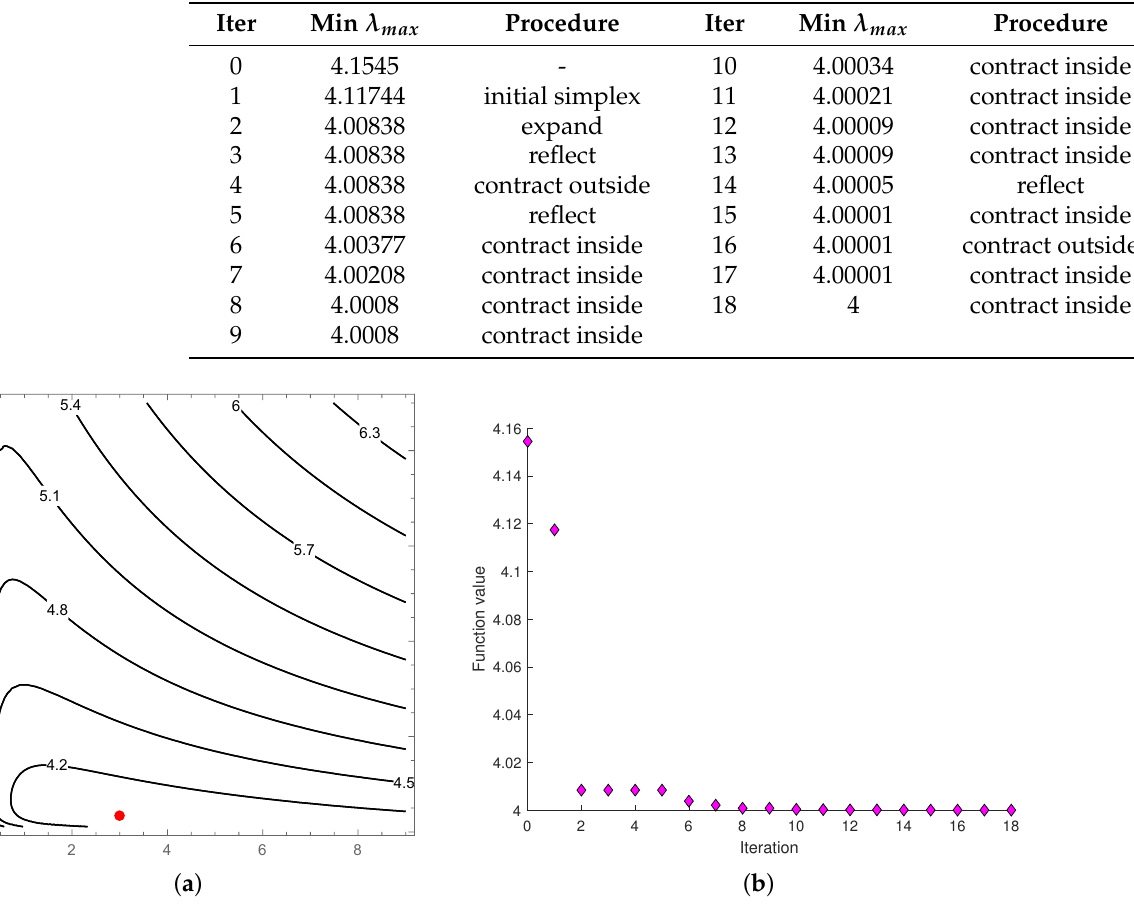
Figure 1. The contour plot of the objective function and the first 18 iterations of the algorithm for minimization (11): ( a ) contour plot on [1/9,9]; ( b ) function value vs.